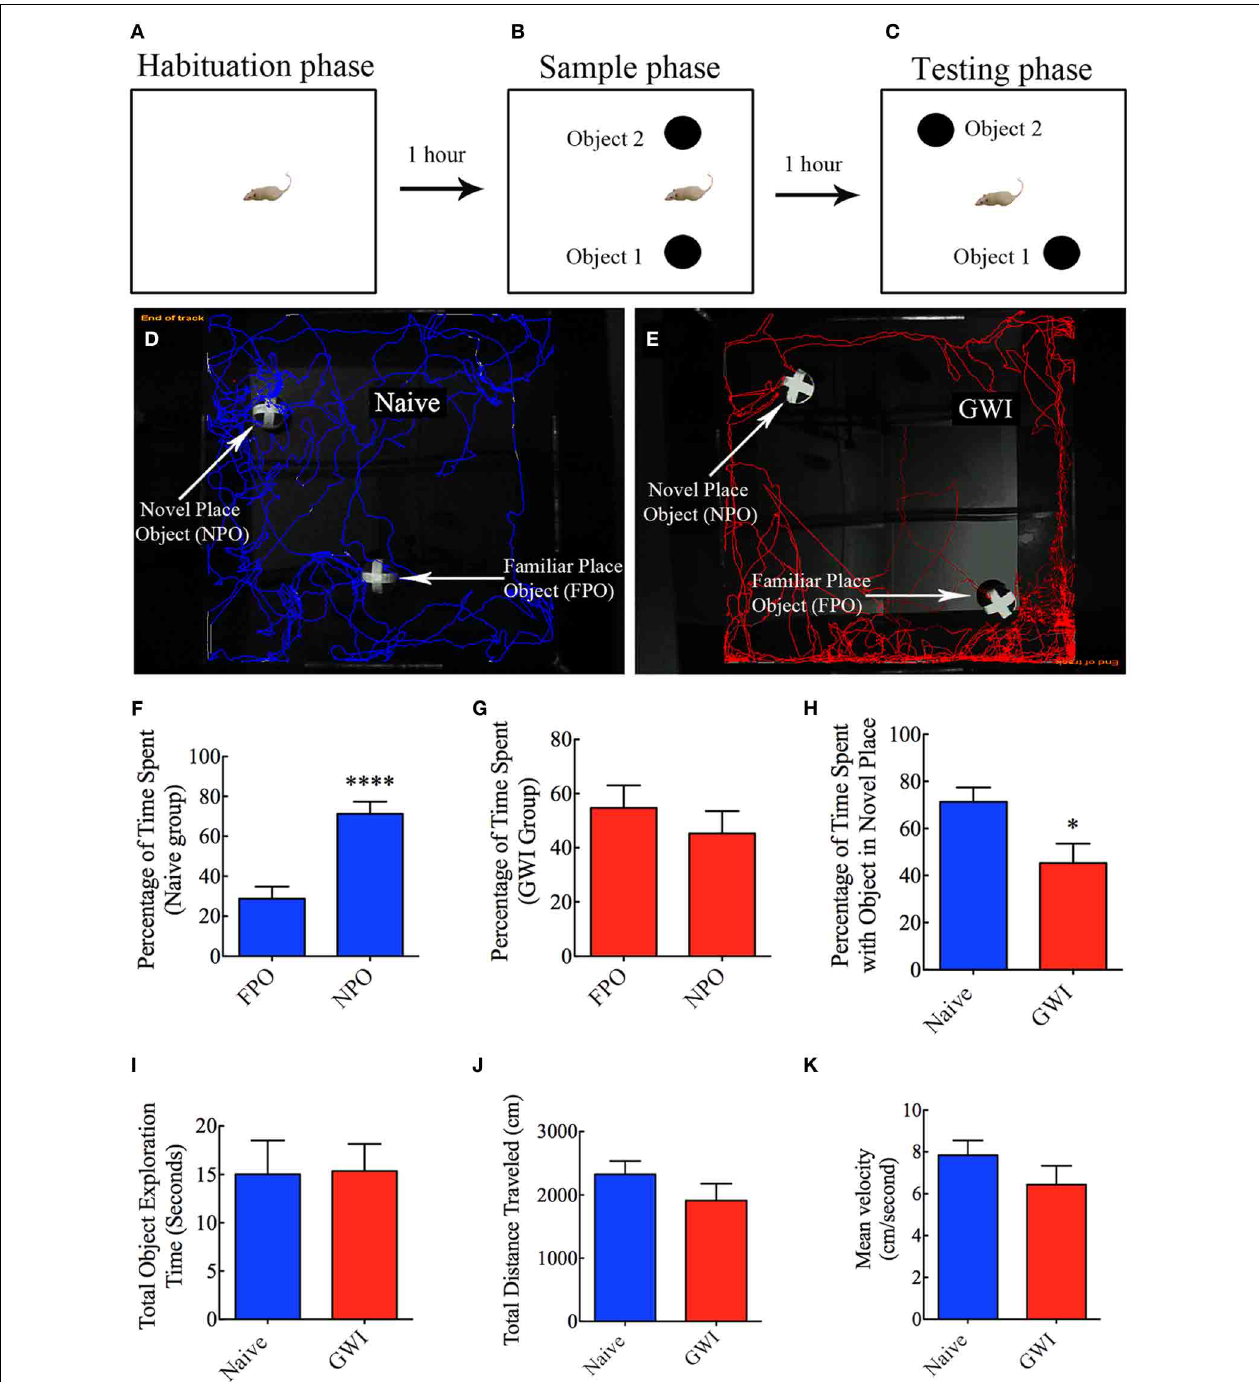
FIGURE 3 | Exposure to Gulf War illness related (GWIR) chemicals and stress causes location memory deficits as revealed by an object location test. (A–C) Show a schematic representation of three trials and inter-trial intervals in this test. (D,E) Show representative track plots of a naive rat (D) and a GWI-rat (E) recorded by Noldus Ethovision XT tracking system in the testing phase. Arrows denote an object that was moved to a novel location (novel place object, NPO) and an object that remained in its original location (familiar place object, FPO) in the testing phase. Note that the naive rat spent more time exploring the moved object (see tracking lines around NPO and